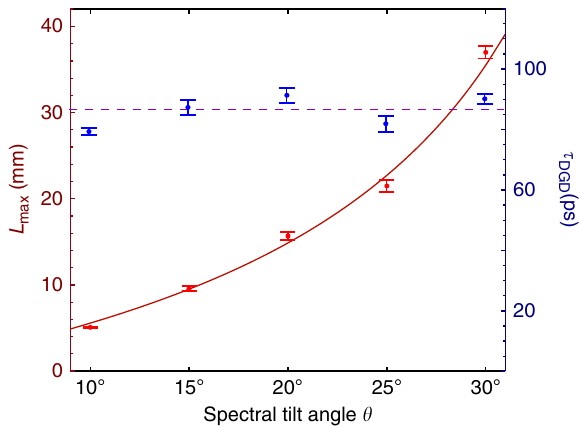
Fig. 6 Propagation distance L max and differential group delay τ DGD against the spectral tilt angle θ ; τ DGD is the difference in group delay between the ST wave packet traveling at a group velocity e v ¼ c tan θ and a luminal reference pulse traveling at e v ¼ c . The propagation distance is extracted from the on-axis time-averaged intensity pro fi les I ( x , z ), where I ð 0 ; L Þ ¼ 1 I ð 0 ; 0 Þ . The error bars correspond to δ L ¼ Δ z = e max the measurement step along z